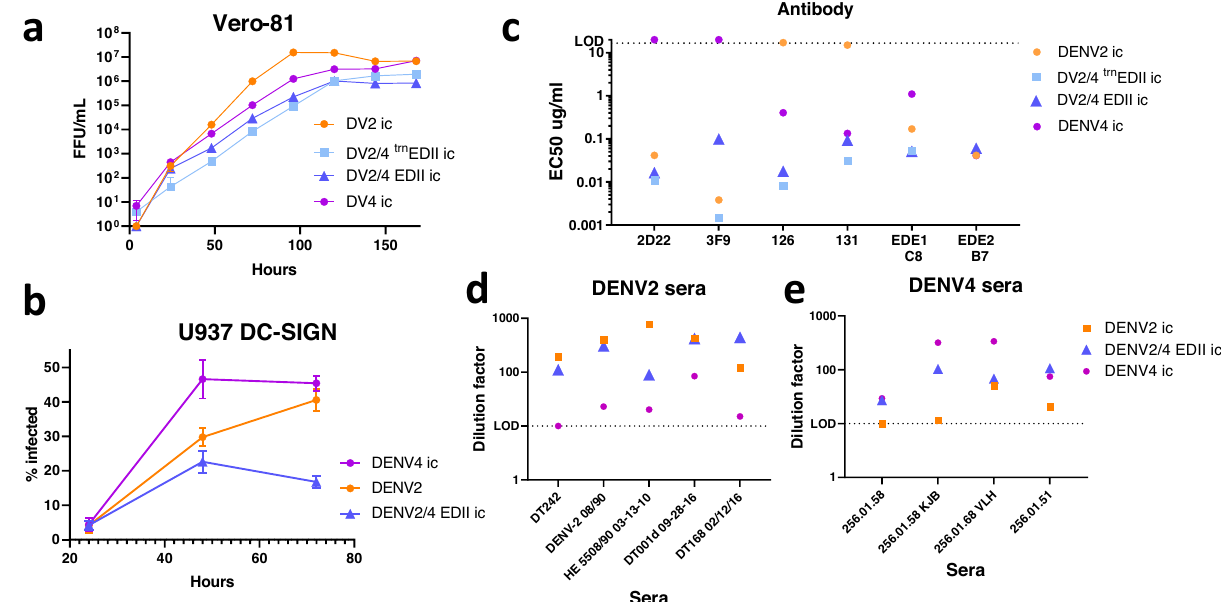
Fig.3|DENV2/4chimeraReplicationandAntigenicity.a BothDENV2/4chimeras are slightly attenuated compared to parental DENV2 and DENV4 but replicate ef fi ciently in Vero-81 cells. Mean+/- SD of triplicate values shown. b DENV2/4EDII replicates ef fi ciently human macrophage cell line U937+DC-SIGN but is slightly attenuated compared to parental DENV2 and DENV4. Mean+/- SD of triplicate valuesshown. c Both DENV2/4chimeras are neutralized byDENV2 mAbs 2D22 and 3F9 as well as DENV4 mAbs 126 and 131. Cross-reactive neutralizing epitopes for